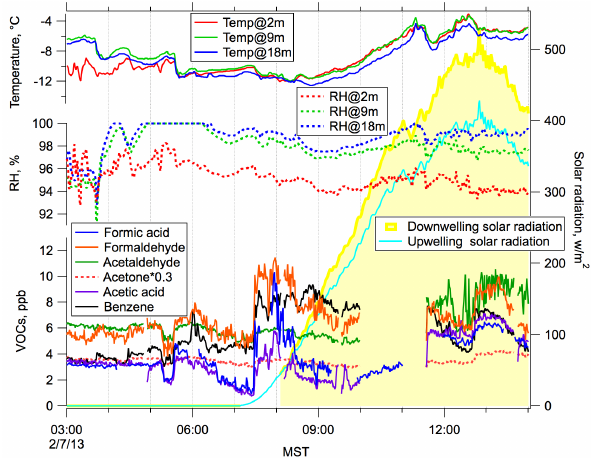
Figure 7. Time series of formic acid and other VOCs (benzene, ace- tone, formaldehyde, acetaldehyde and acetic acid) during the fog event on the morning of 7 February 2013 in UBWOS 2013. Mea- sured ambient temperature and relative humidity (RH) at different heights (2, 9 and 18m) and downwelling and upwelling solar radi- ation are also